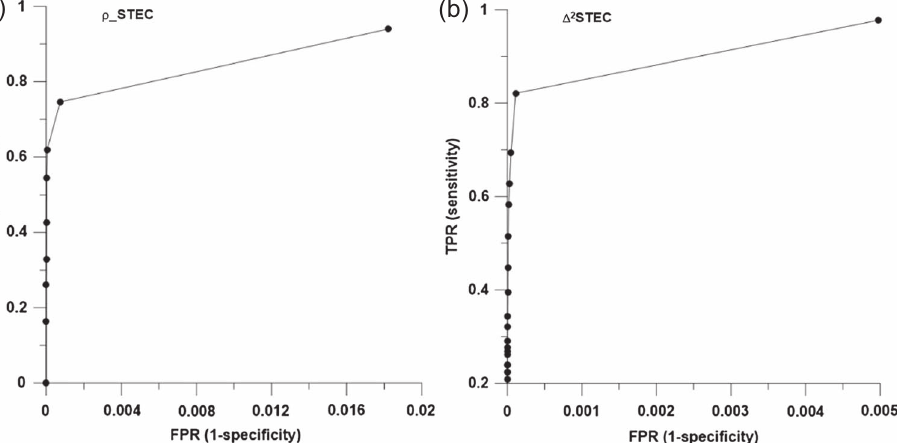
Fig. 10. (a) ROC curve for correlation and (b) ROC curve for D 2 STEC. In both cases, we only show the left part of the curve to depict where the in fl ection point is achieved.